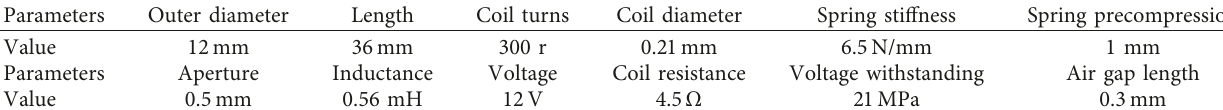
Table 2: Structural parameters of the miniature high-speed digital valve.